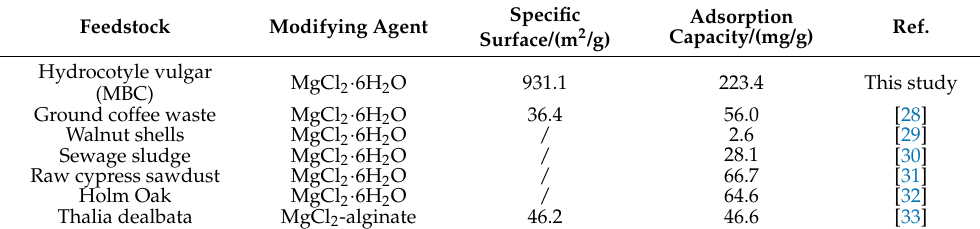
Table 1. Comparison of phosphate adsorption capacity by relevant adsorbents.